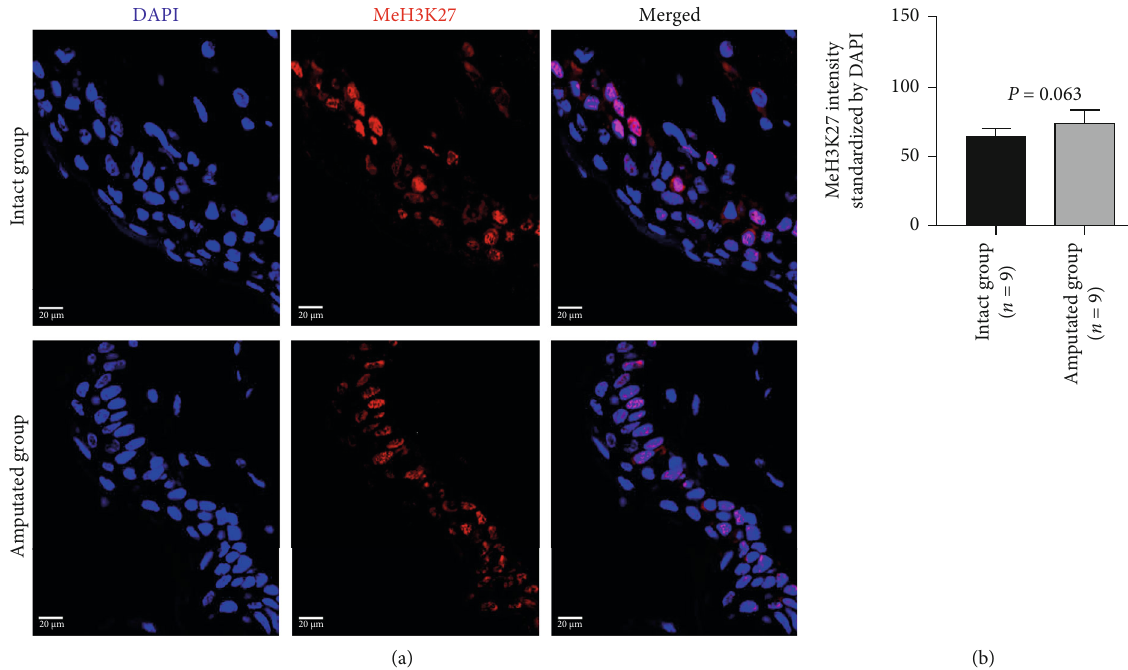
Figure 6: Immunohistochemical analysis on the methylation of H3K27 in tissue cells 3 days after amputation. Representative images (a) and quantitative data (b) show the expression with methylated H3K27 (MeH3K27) in intact tails and amputated tails. Quantitative data was normalized by DAPI. Scale bar: 20 μ